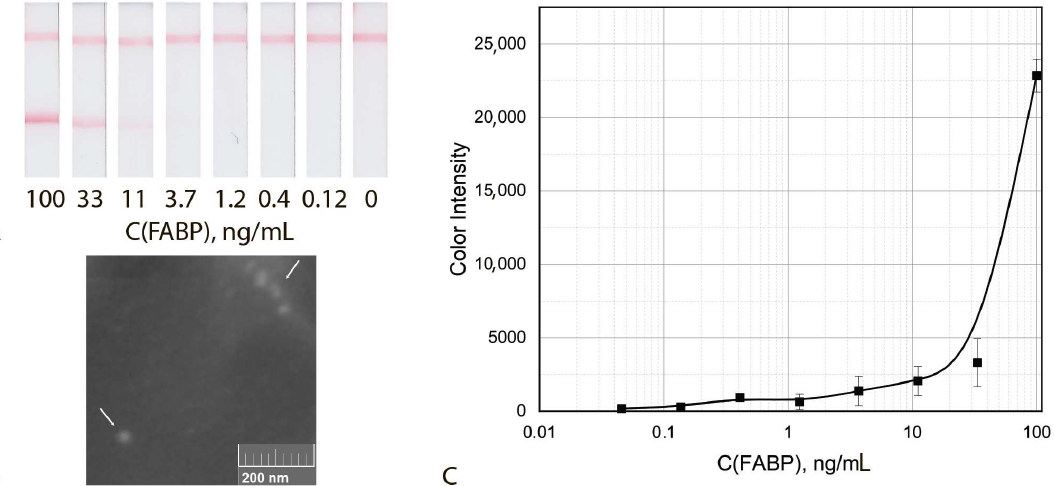
Figure 4. Common ICA protocol: Appearance of test strips ( A ), SEM image of the sGNPs bound in the analytical zone ( B ) and calibration curve for FABP detection in serum ( С ) ( n = 5).